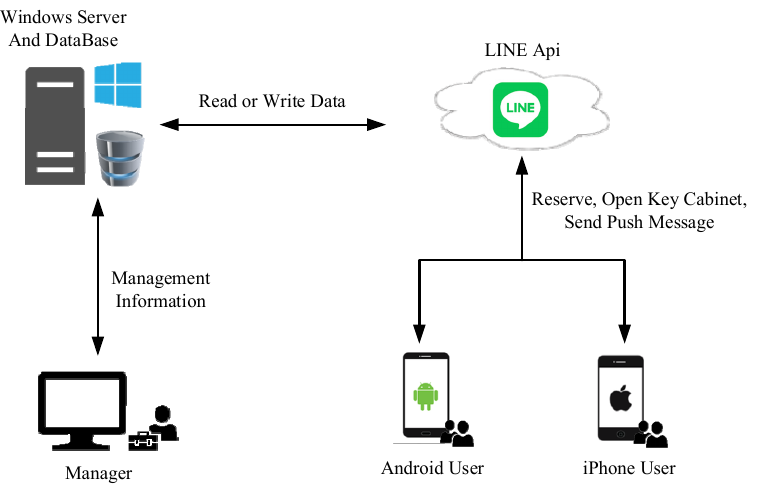
Figure 12. Cloud system structure diagram.